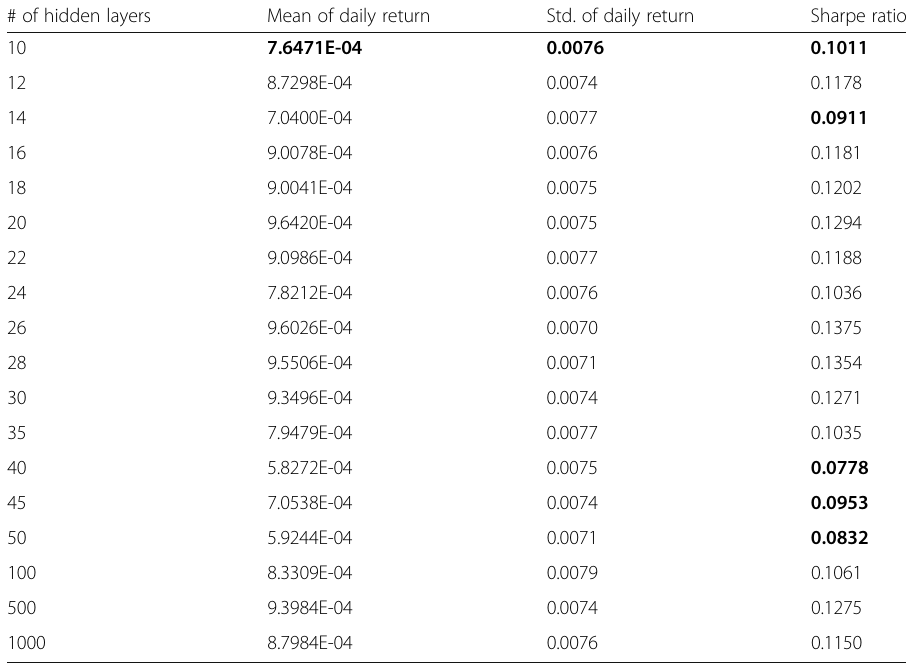
Table 7 Simulation results with ANN/DNN classifiers using transformed data with PCs = 60 # of hidden layers Mean of daily return Std. of daily return Sharpe